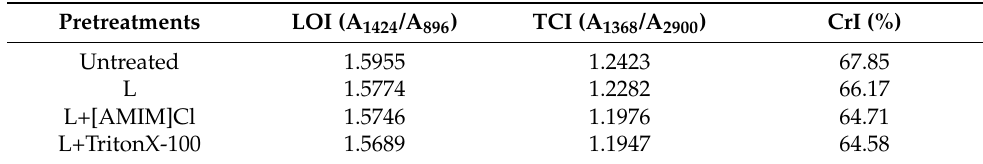
Table 2. LOI, TCI, and CrI of untreated and pretreated rice